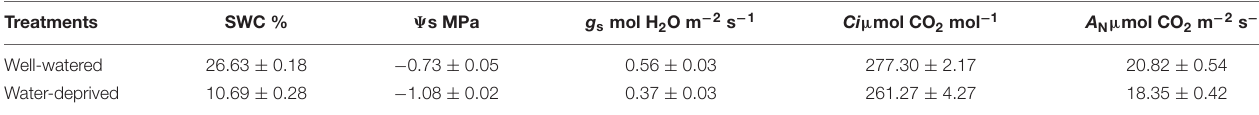
TABLE 1 | Soil water content (SWC), stem water potential ( (cid:57) s), stomatal conductance ( g s ), CO 2 concentration ( Ci ), and photosynthetic rate ( A N ) in leaves (graft, var. Catherina) in control and drought-stressed plants after 16 days. Treatments Well-watered Water-deprived